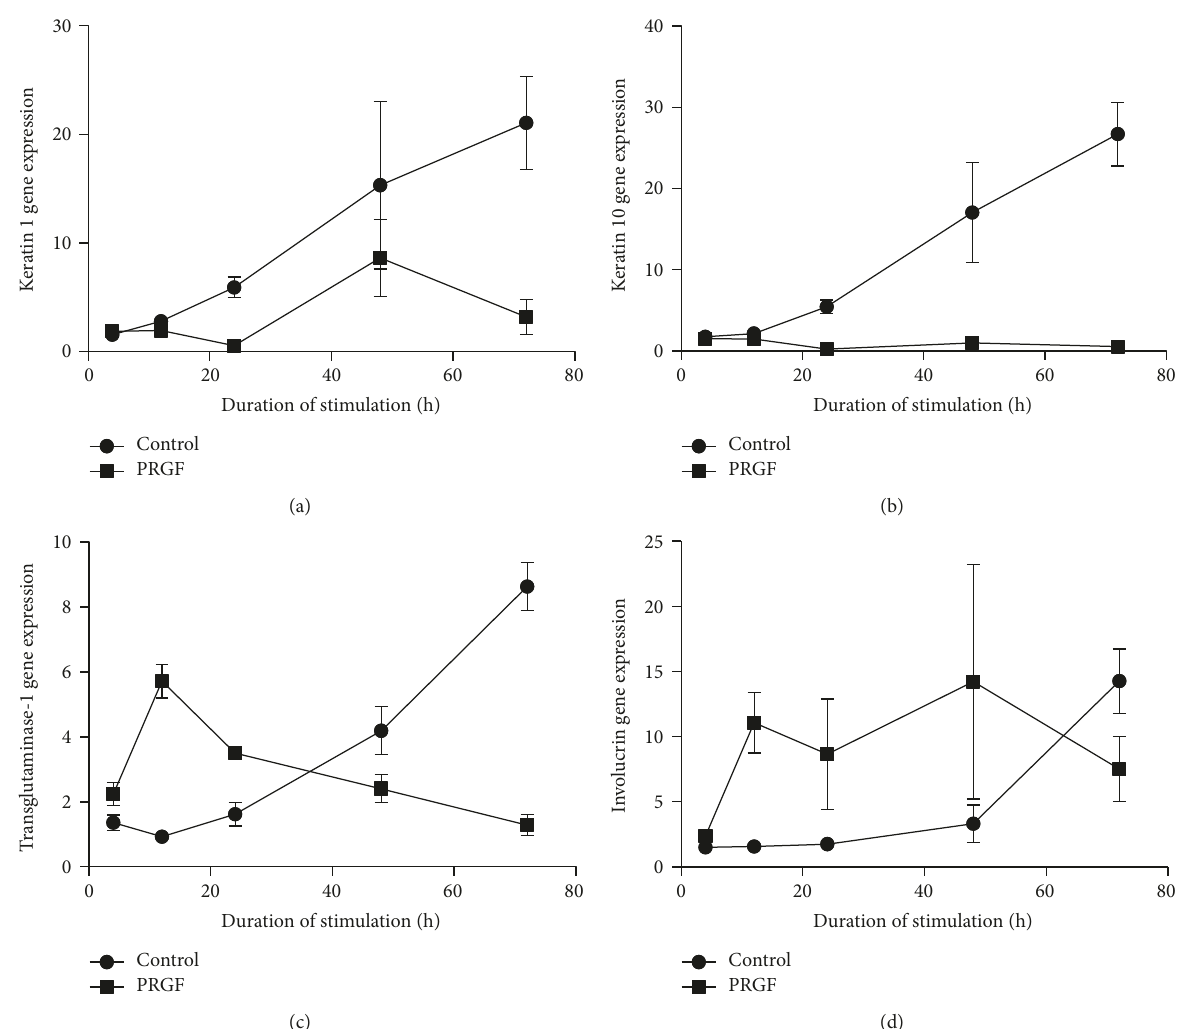
Figure 2: Time-dependent in fl uence of PRGF on the expression of di ff erentiation markers. PRGF stimulation (1 :10) of primary keratinocytes caused a time-dependent decrease of keratin 1 (a) and keratin 10 (b) gene expression paralleled by a time-dependent increase of transglutaminase-1 (c) and involucrin (d) gene